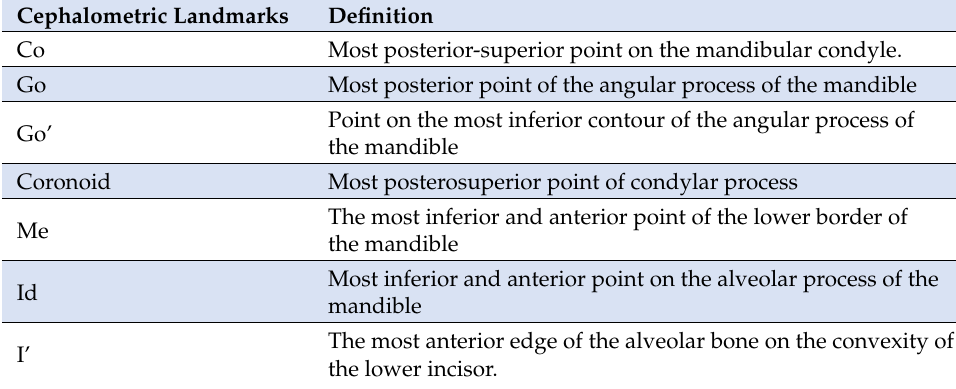
Table 2. Cephalometric landmarks.